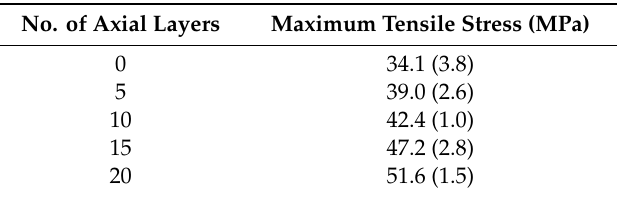
Table 2. Tensile test the maximum stress of each group.